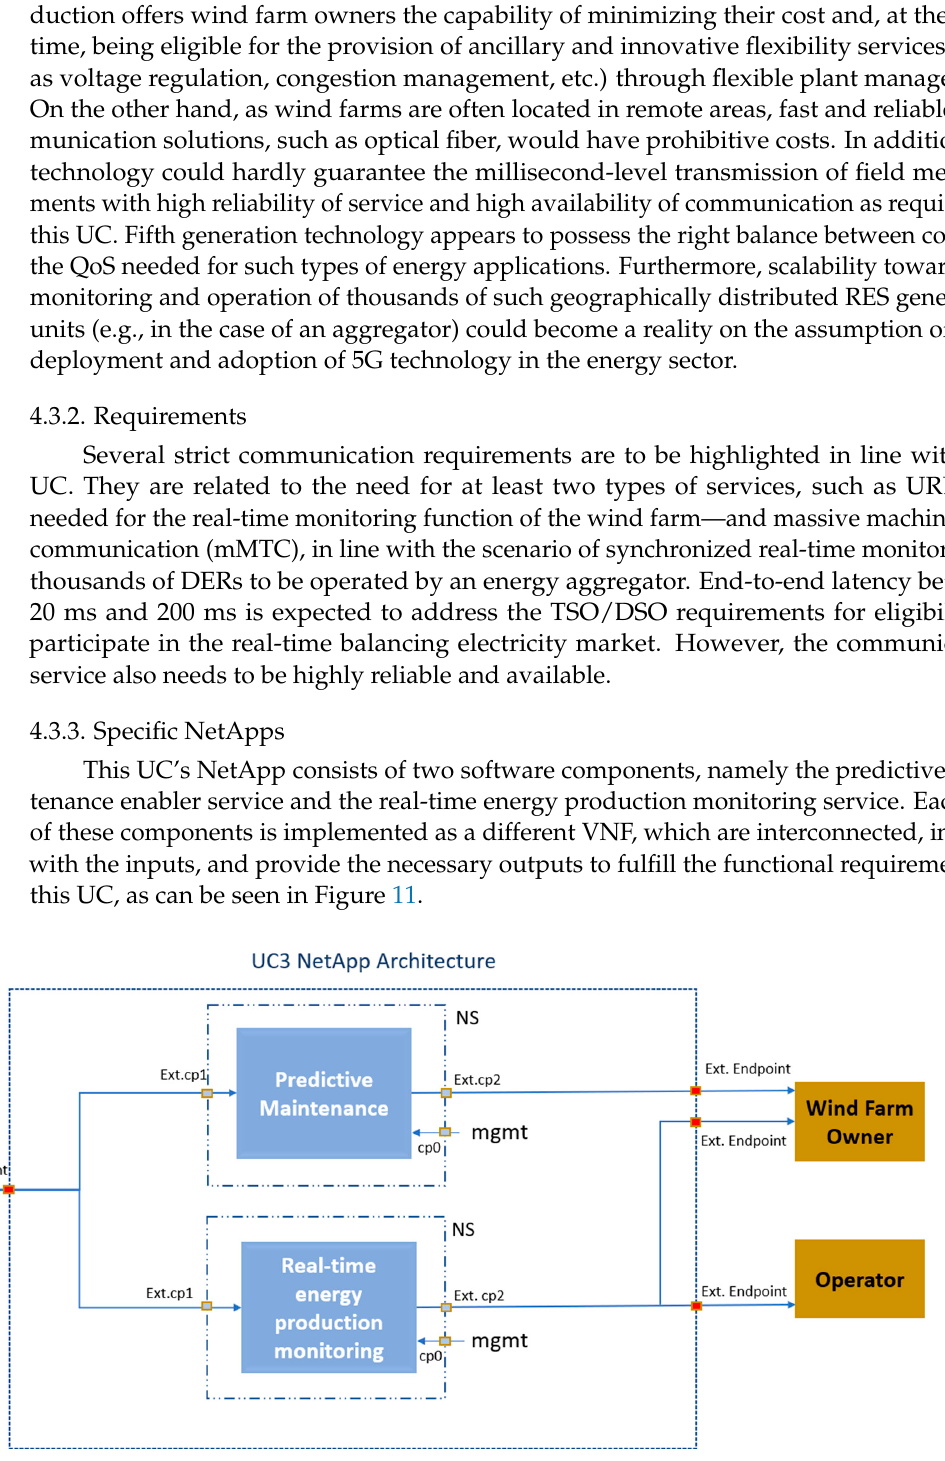
Figure 11. NetApp architecture of